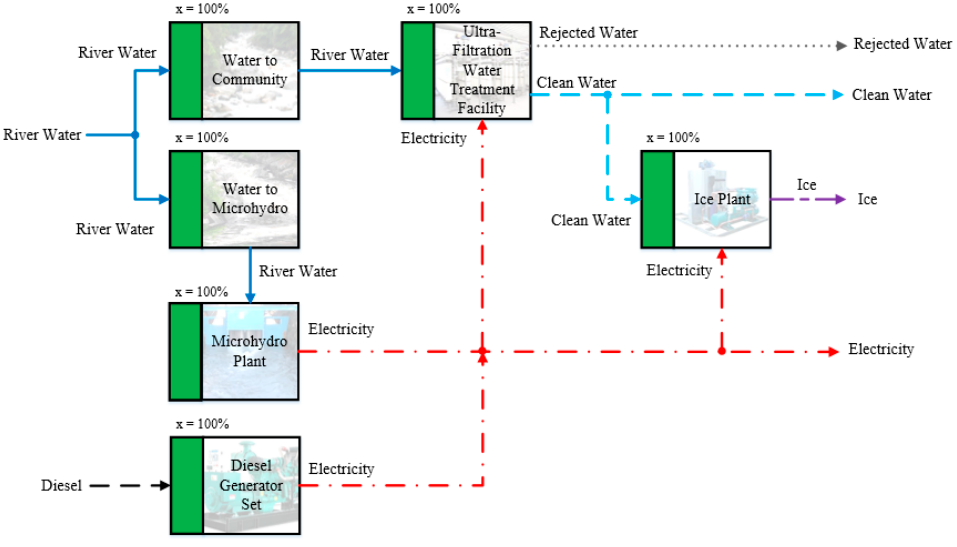
Figure 5. The process flowsheet of the polygeneration system of case study 2.